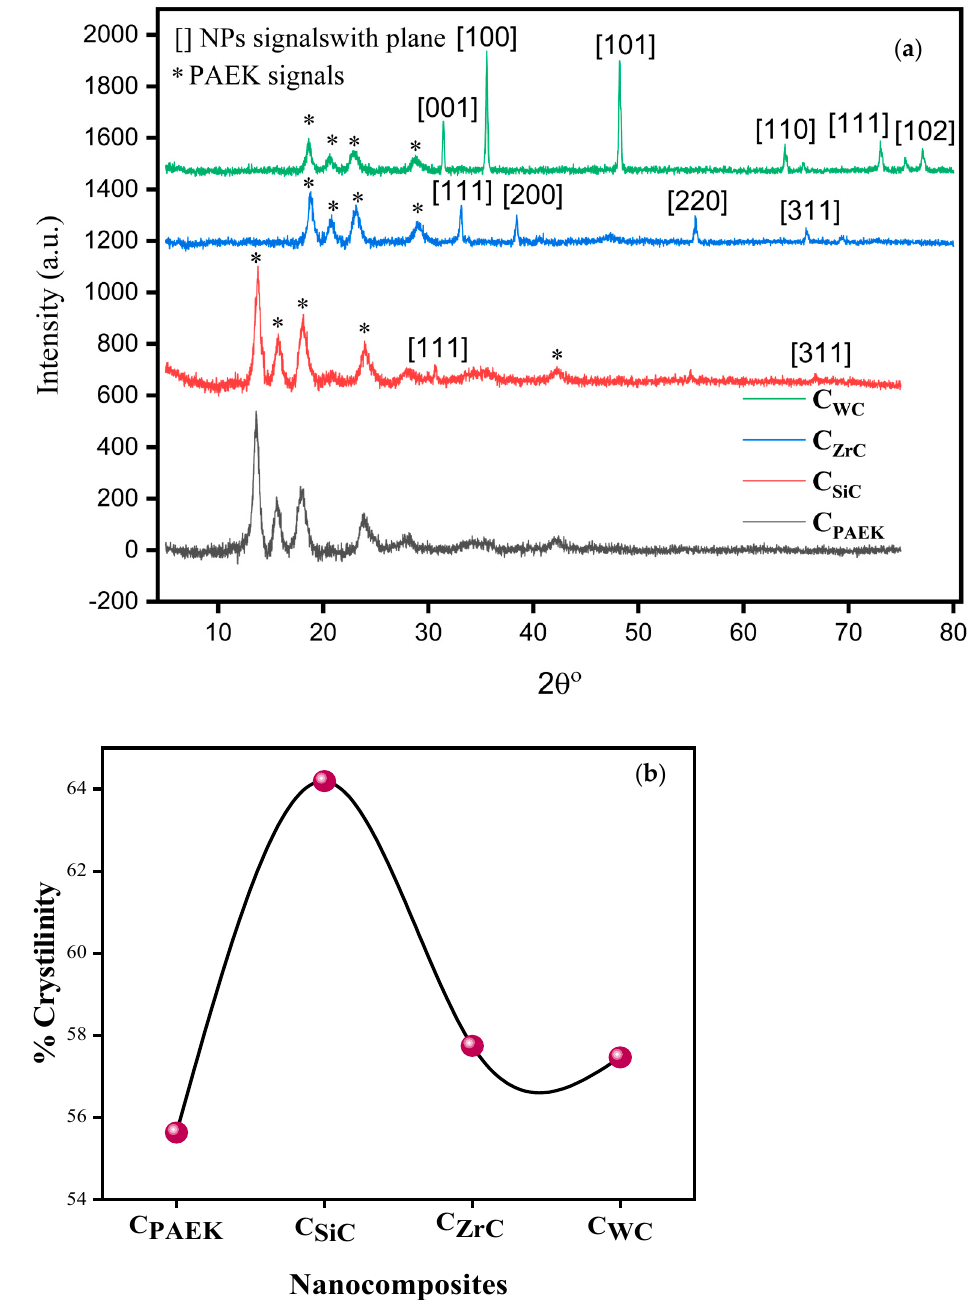
Figure 5. X − ray diffraction (XRD) pattern of pure C PAEK and C SiC , C ZrC , and C WC , composites ( a ) and ( b ) shows the extent of % crystallinity.